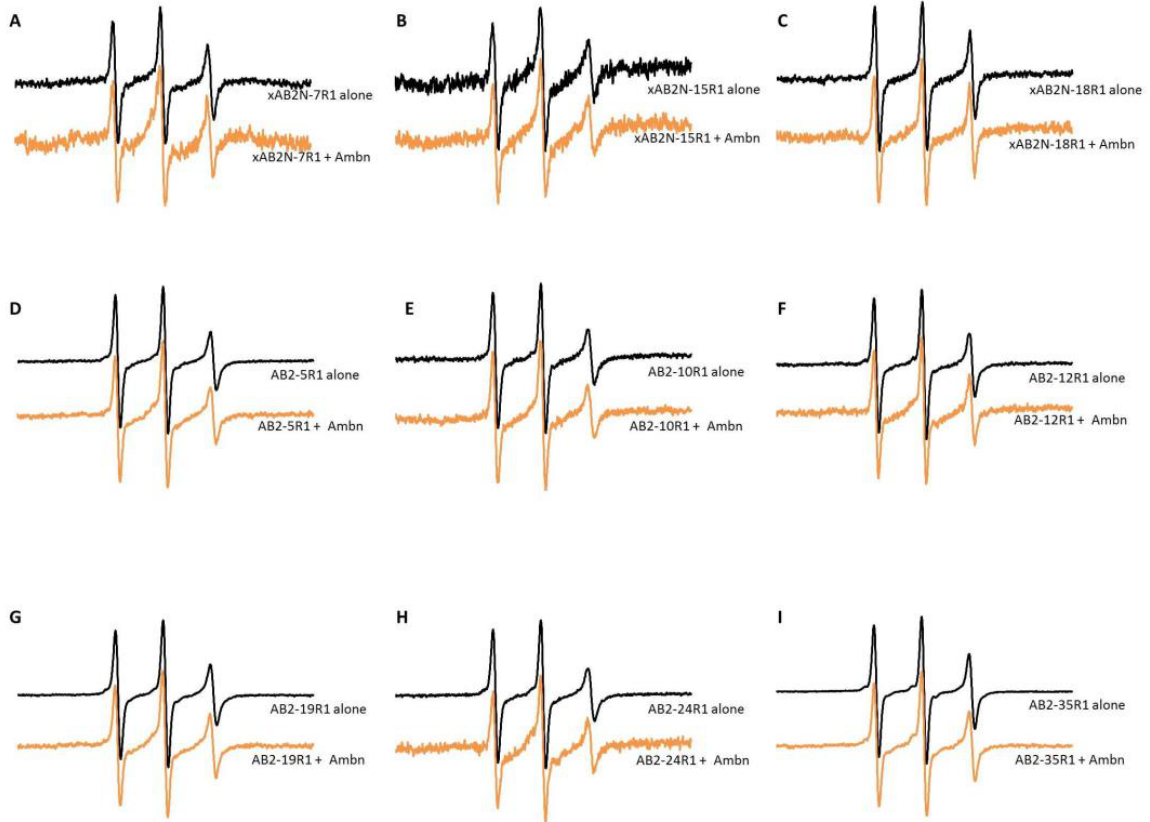
Figure 4. Representative EPR spectra of 15 µ M peptide with and without 0.3 mg/mL unlabeled full-length Ambn. xAB2N spin-labeled at positions ( A ) 7, ( B ) 15, and ( C ) 18 and 15 µ M AB2 spin-labeled at positions ( D ) 5, ( E ) 10, ( F ) 12, ( G ) 19, ( H ) 24, and ( I ) 35.